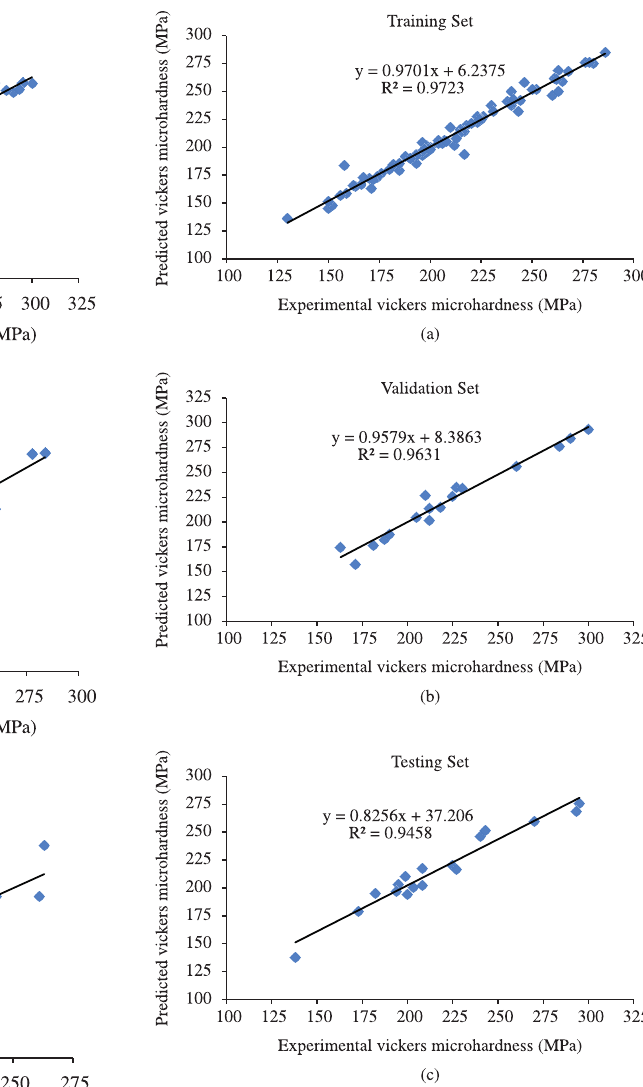
Figure 7. The correlation of the measured and predicted Vickers microhardness values in a) training, b) validation and c) testing sets for ANFIS-II